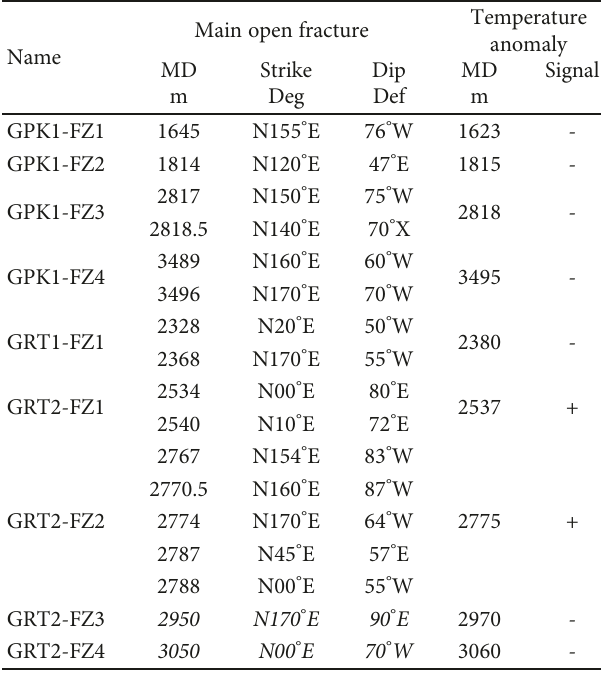
Table 1: Temperature anomalies in well GPK-1 in Soultz and GRT- 1 and GRT-2 in Rittersho ff en. Structural data from the main open fractures in the FZs, as well as the polarity and depth of the anomalies, are presented. Structural data in italics indicate that acoustic images are not available. For GRT-2, values are calculated from oriented calipers [41].